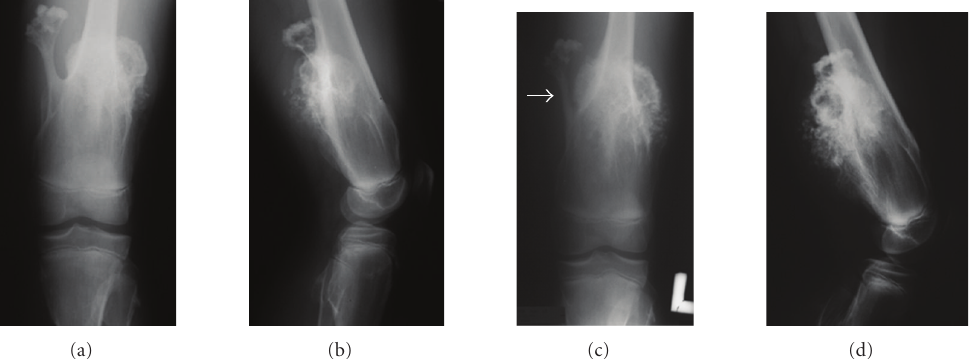
Figure 4: (a) Anteroposterior radiograph reveals the large osteochondroma of the left distal femur in a 13-year-old with MO. (b) Lateral view further depicts the size of the large osteochondroma of the left distal femur. (c) Six-month follow-up anteroposterior radiograph, illustrating the obvious growth of the posterolateral lesion of the distal femur compared to the posteromedial osteochondroma, including erosion into the posteromedial osteochondroma by the tumor (arrow). (d) Six-month follow-up lateral radiograph reveals irregular calcifications within the cartilage cap, cortical erosions, and indistinct osseous margins, all suggesting malignant progression of the posterolateral osteochondroma of the distal